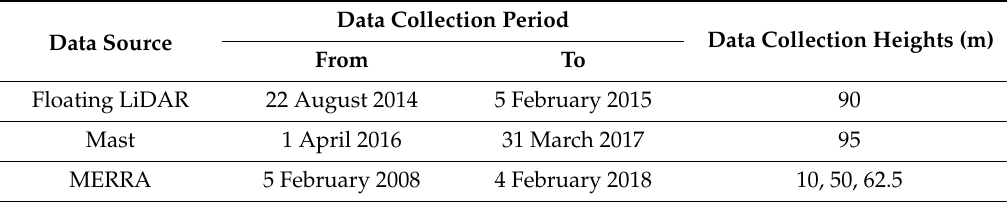
Table 3. Data collection periods for floating LiDAR, mast, and